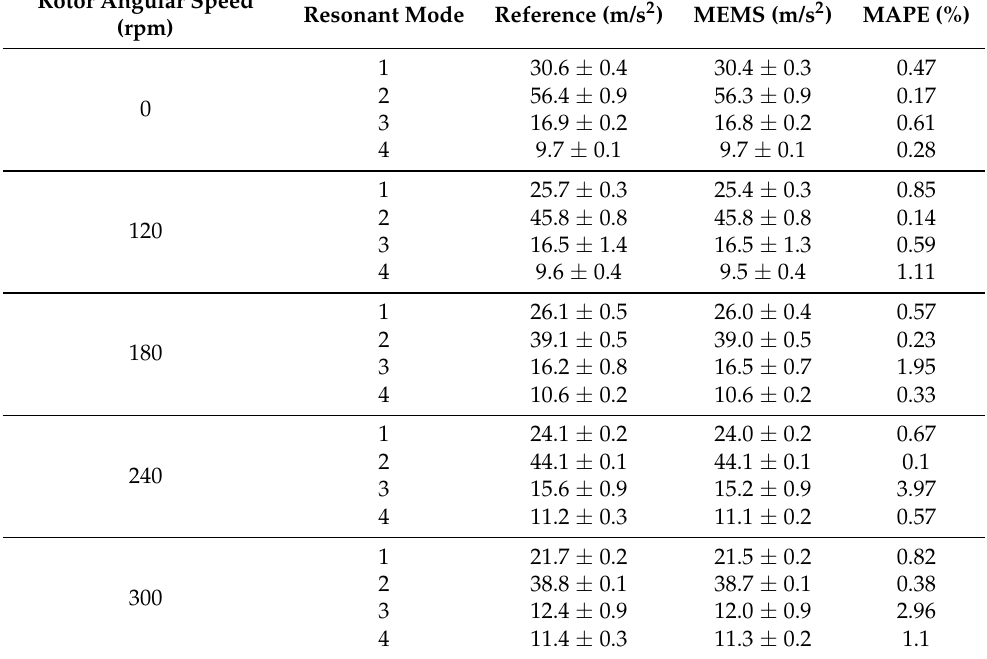
Table 3. Mean acceleration amplitude ± standard deviation calculated from both the acceleration measurement systems (Reference and MEMS-based system).